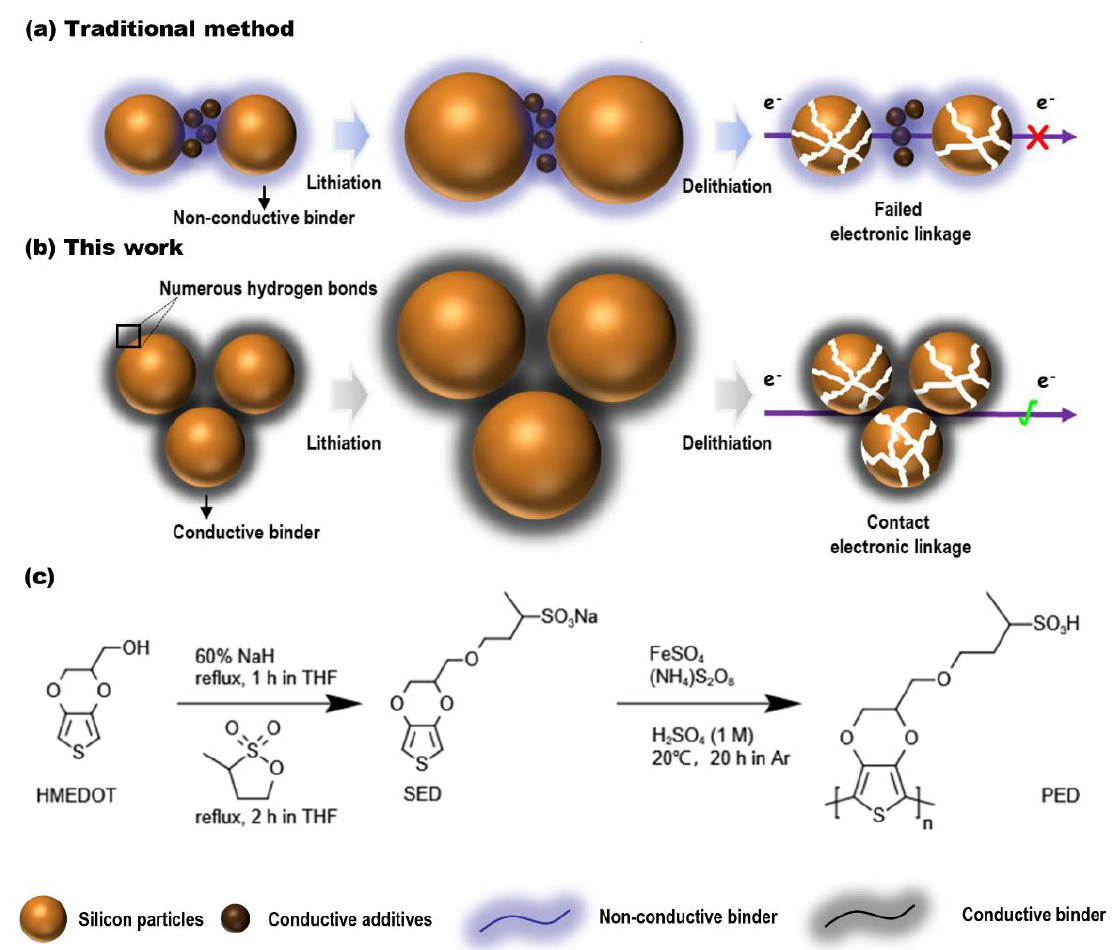
Figure 1. Schematic illustration of the structure of Si electrode during discharge and charge process. ( a ) Traditional method uses carbon black (CB) as the conductive additive and PVDF as binder, lead − ing to broken electric contacts; ( b ) novel approach uses conductive bifunctional binders com − posed of PED and PAA, which could maintain both the electrical and mechanical stability of the electrode during repeated charge/discharge cycles; ( c ) synthetic route to the PED.